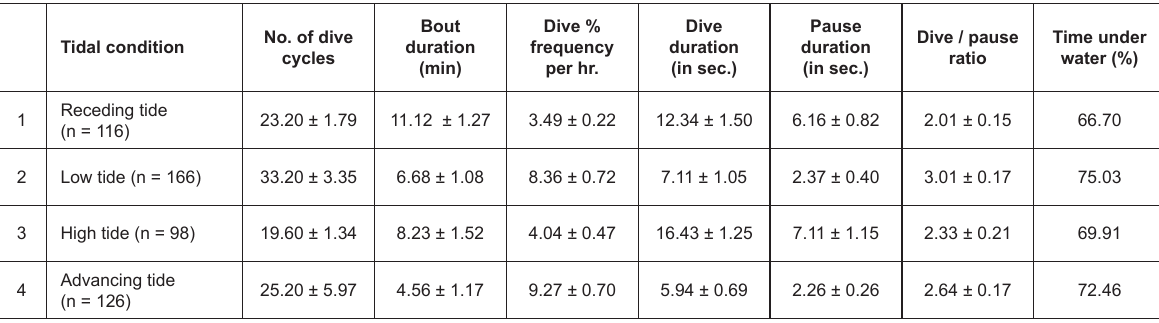
Table 1. Mean diving parameters for the foraging Little Cormorant